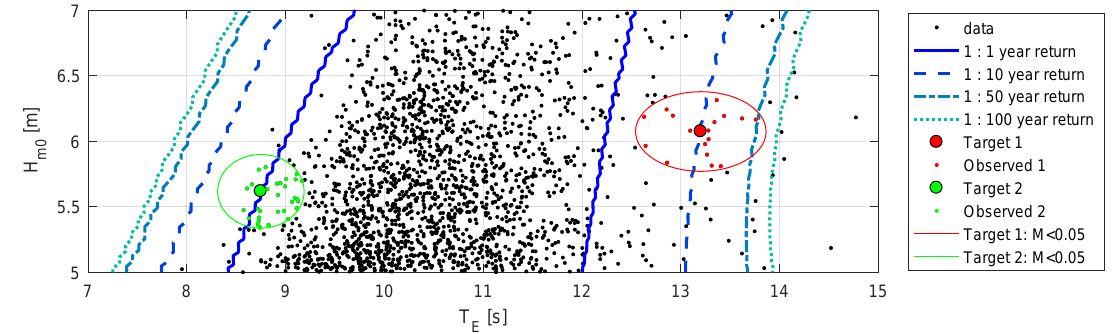
Figure 14. Scatter diagram displaying identified example points for demonstrating spatial variability. Target values and observed values used for comparison are